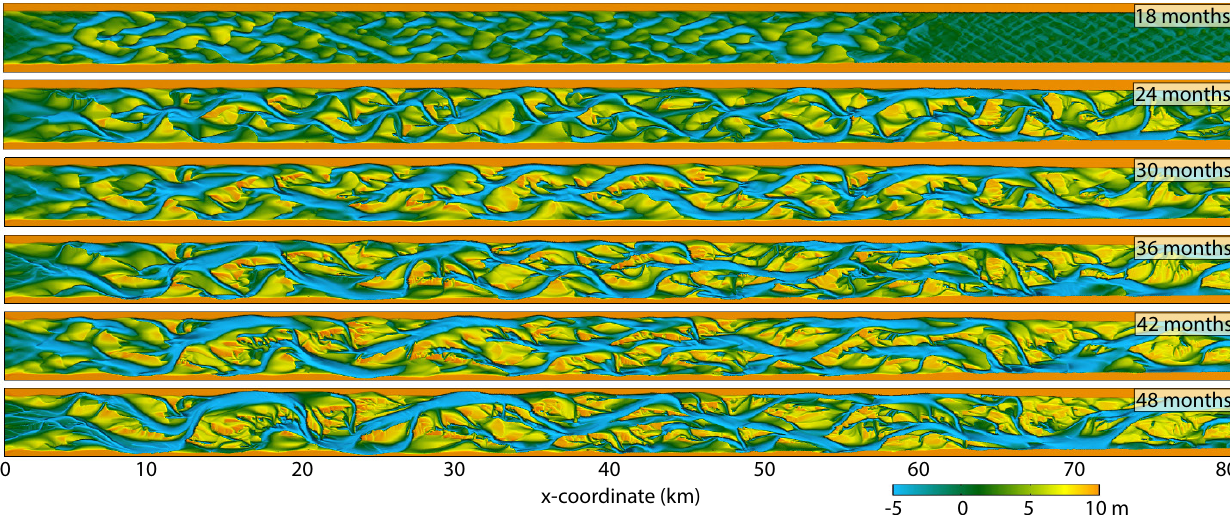
Figure 3. Evolution of a braided channel network and bar pattern in the case of erodible floodplains and yearly